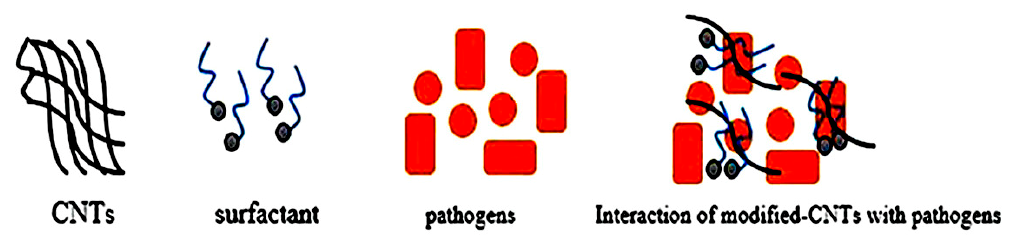
Figure 2. Schematic illustration of surfactant-modified carbon nanotubes (CNTs) and their possible interaction with the pathogens.